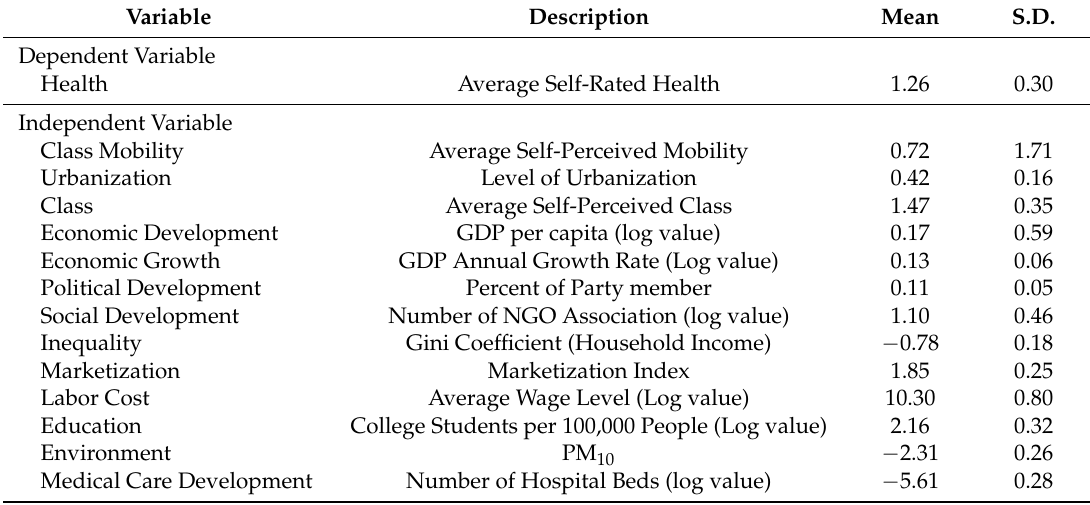
Table 2. Descriptive Statistics for Selected Provincial-Level Variables